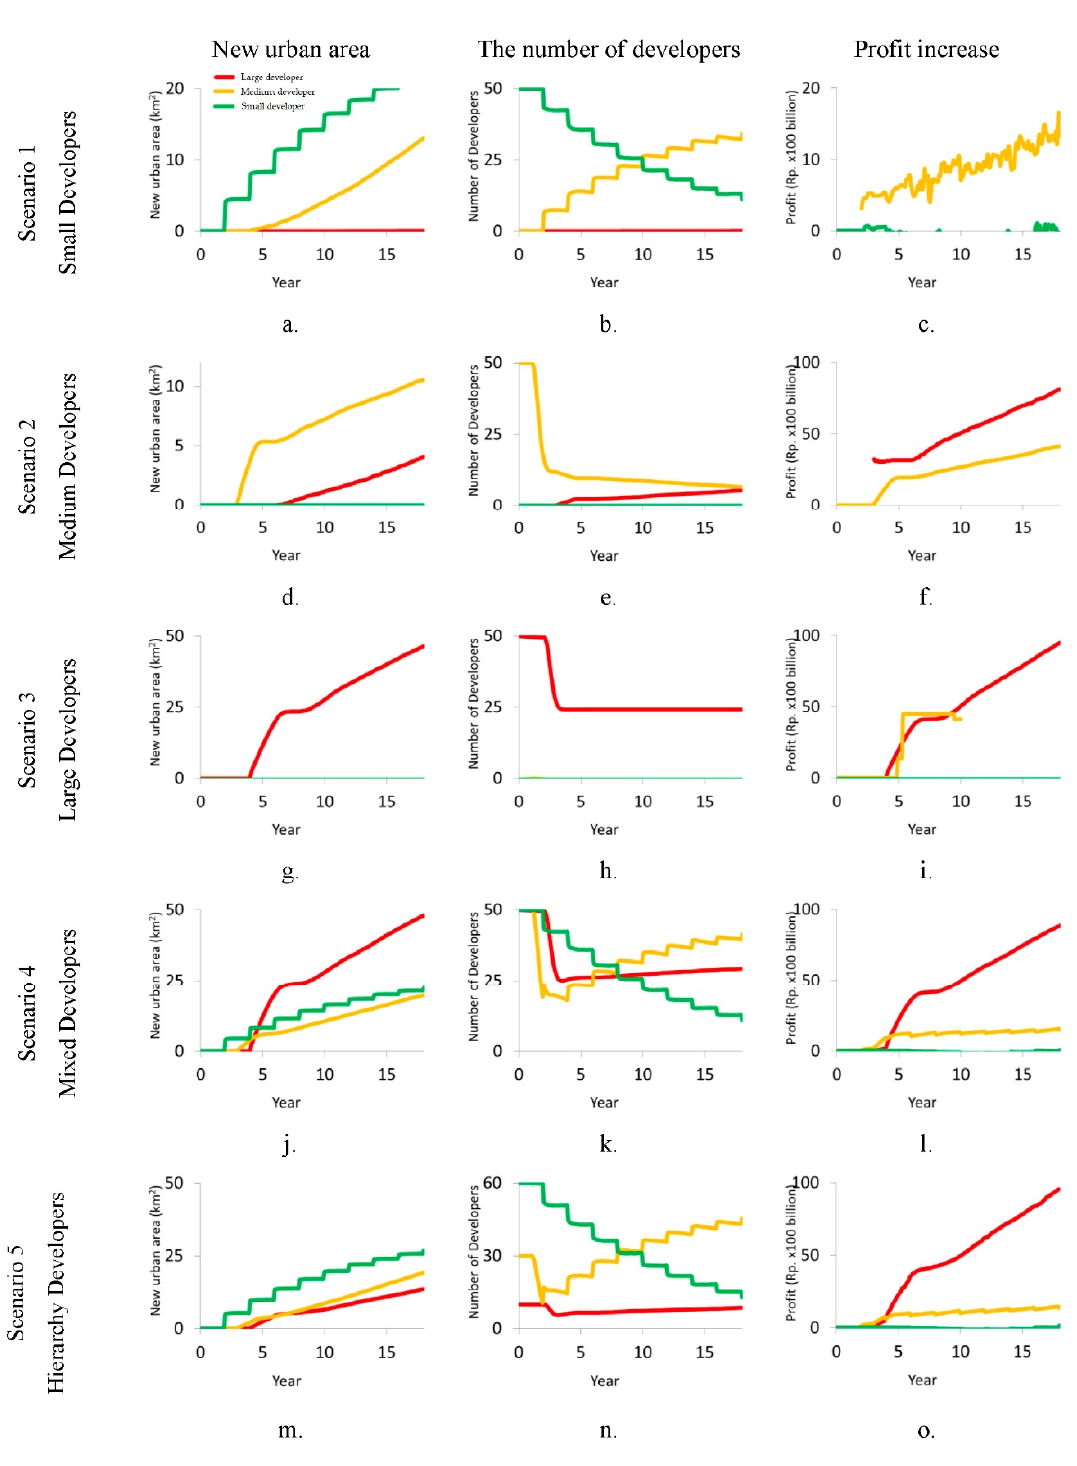
Figure 7. New urban areas; number of developers and profit increase from 100 simulations under five scenarios.